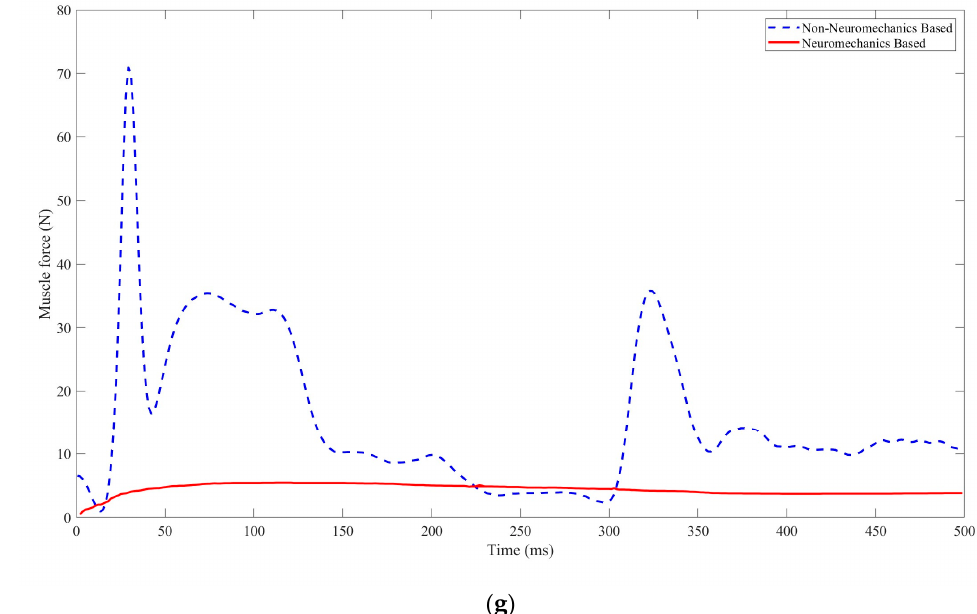
Figure 9. The muscle activity and forces during the arm reaching movements are compared between the neuromechanics—based and non—neuromechanics-based controllers. Subfigures ( a – g ) depict the muscular activities of skeletal muscles 1–7 during planar arm reaching movements.